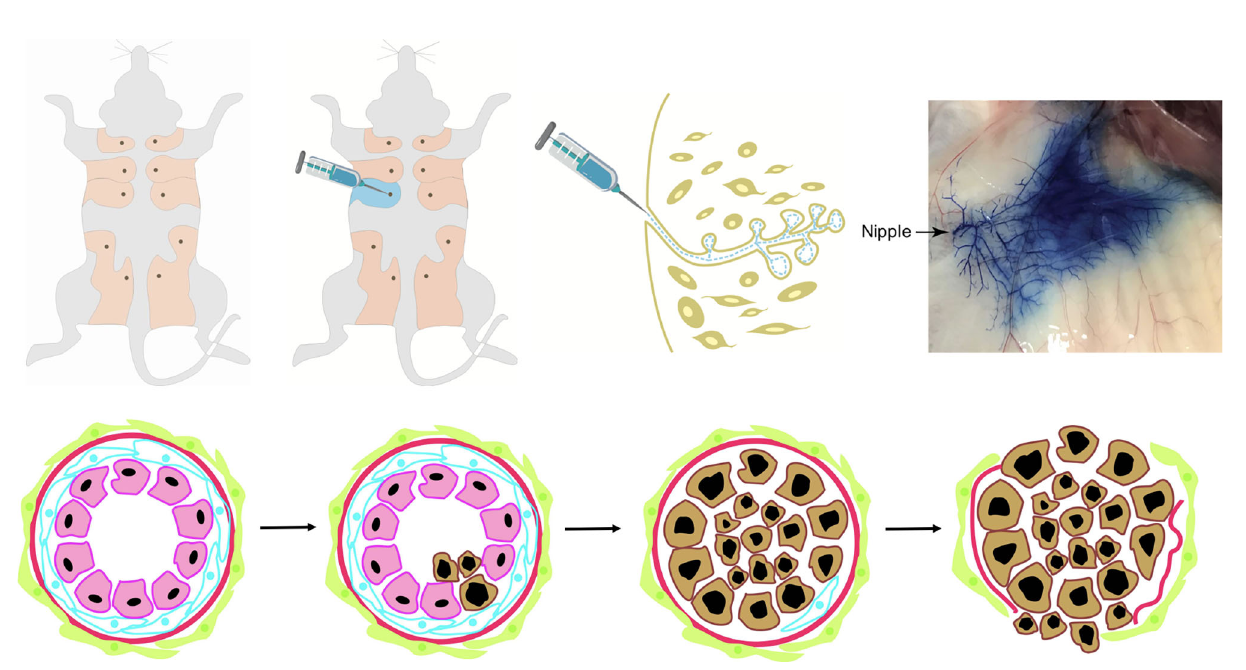
FIGURE 1 | The intraductal injection of retrovirus into mammary glands in vivo with virus vector initiates and promotes carcinogenesis in mouse models. It is a novel mouse mammary gland cancer model which mimics human breast cancer non-invasive-to-invasive progression with virus vector. Most human breast cancers are not due to hereditary mutations, rather they arise from normal cells that later suffered spontaneous mutations. This mouse model was established by intraductal injection of retrovirus carrying the oncogenes with blue dye into one of the fi fth mouse mammary glands. The technique of virus-mediated gene transfers into selected mammary cells (such as stem cells and speci fi c progenitor cells) at selected times can overcome many of the shortcomings of the existing mouse models and more closely mimics human breast cancer formation in which only one or a few cells mutate to initiate cancer development. It allows temporal analysis of many processes involved in early breast cancer invasive progression including intraductal cancer cell growth, the cell interactions with the surrounding normal epithelial and myoepithelial cells, and their escape into the surrounding stroma. Photo of nipple injection – courtesy of Wen Bu (Baylor College of